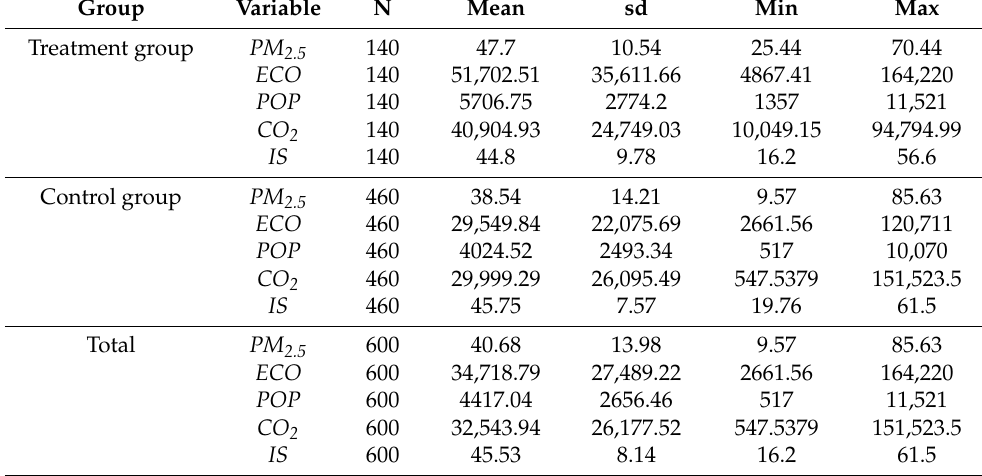
Table 3. Descriptive